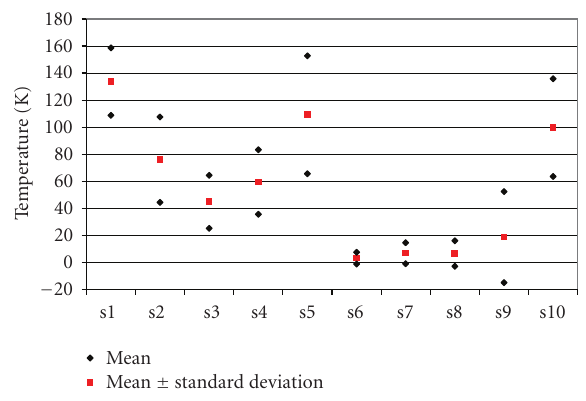
Figure 12: Sensitivities mean Δ PCT values—Scalar